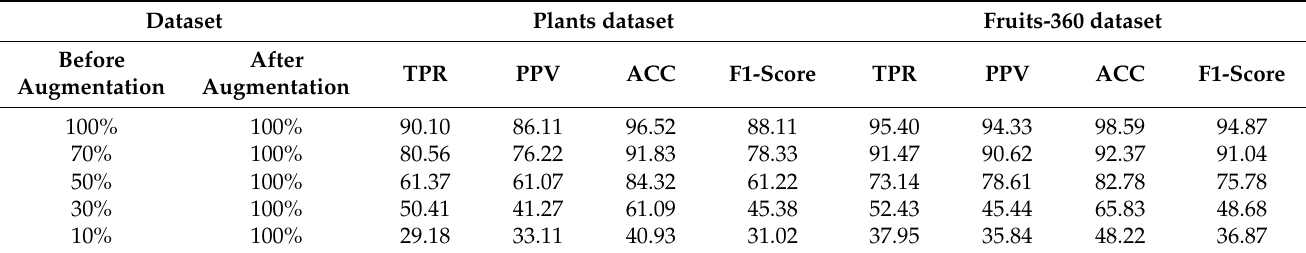
Table 24. Comparison of accuracies achieved by the proposed PI-CNN in the original and augmented datasets. The accuracies were achieved in the Plants and Fruits-360 dataset (unit: %).